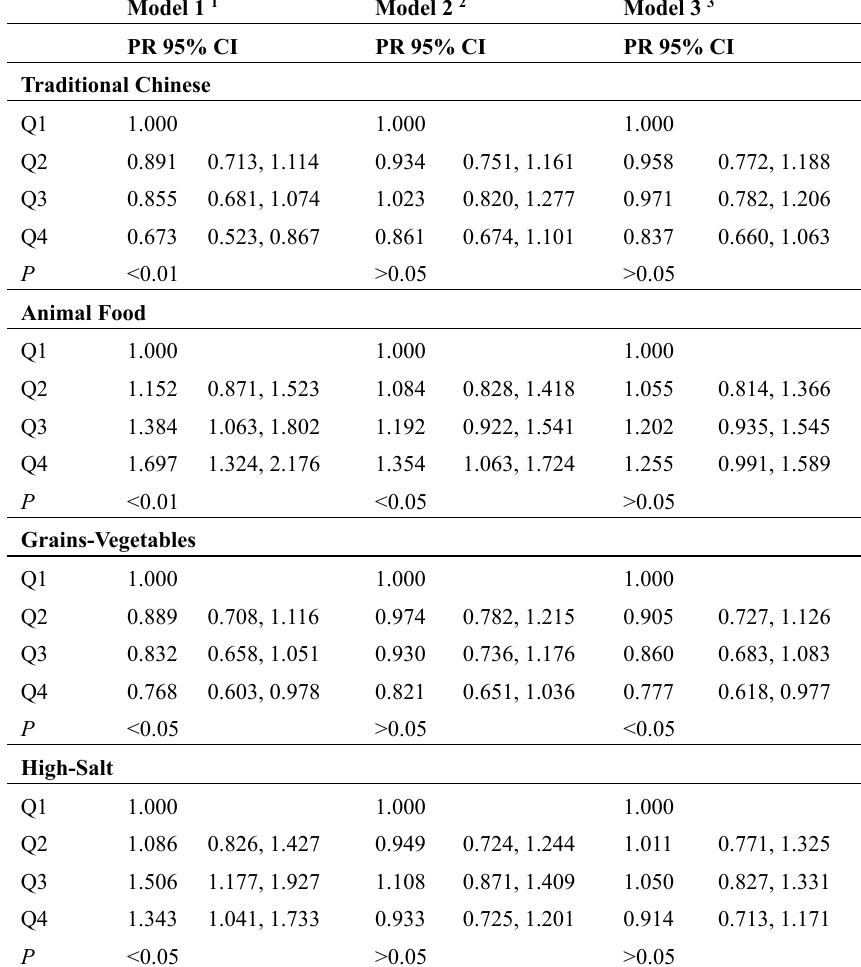
Table4. Multivariable models adjusted for non-alcohol fatty liver disease across the quartile (Q) categories of the dietary patterns in Anhui Province,